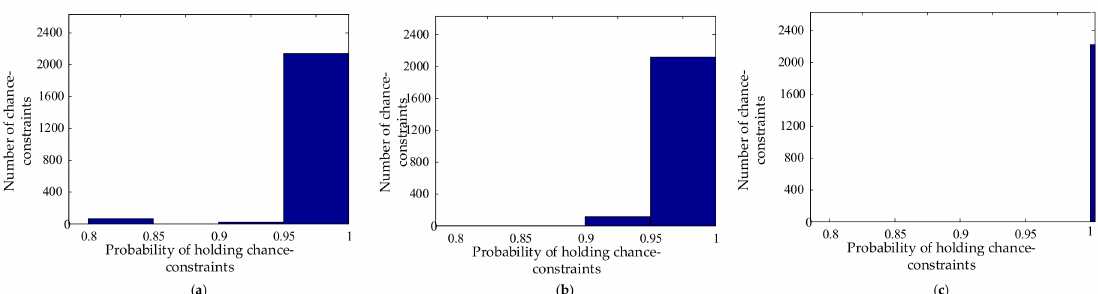
Figure 6. Probability histogram of chance constraints in IEEE 30-bus system with different confidence levels. ( a ) 1 − ε = 0.8; ( b ) 1 − ε = 0.9; ( c ) 1 − ε =